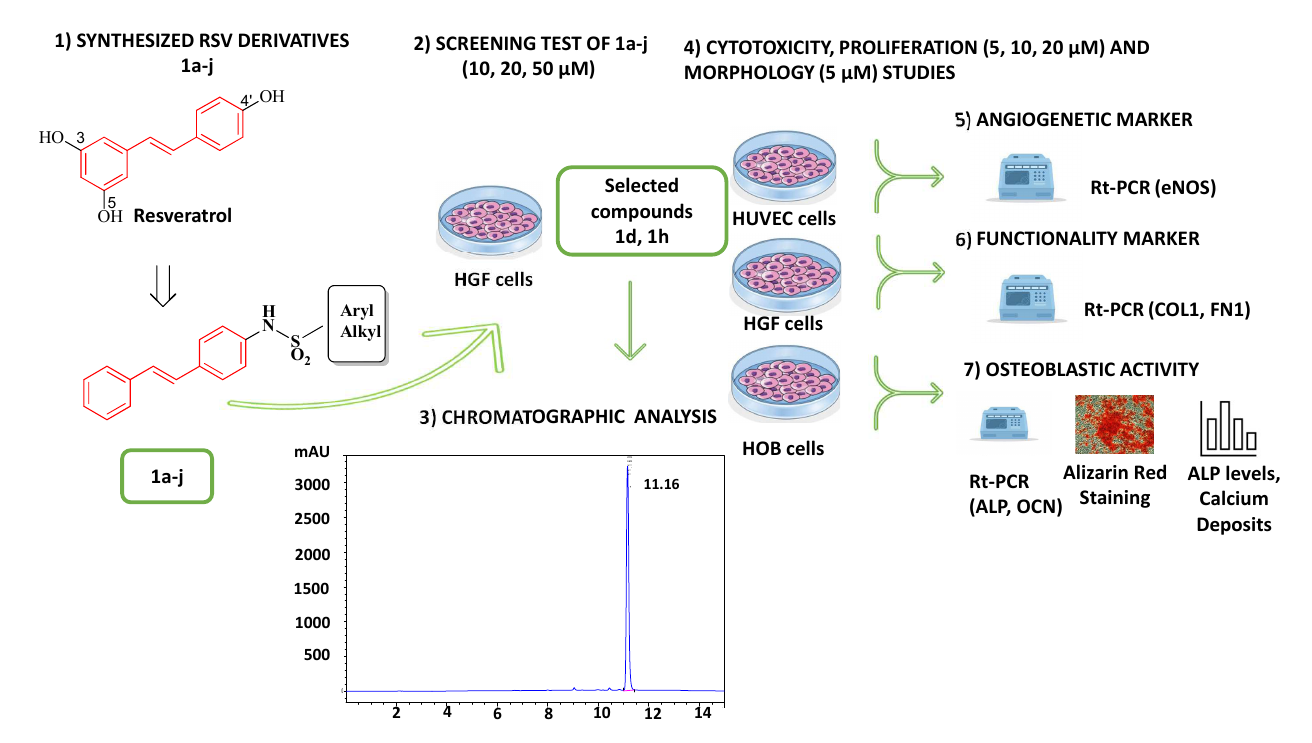
Figure 18. Experimental design of the study (described in detail in the